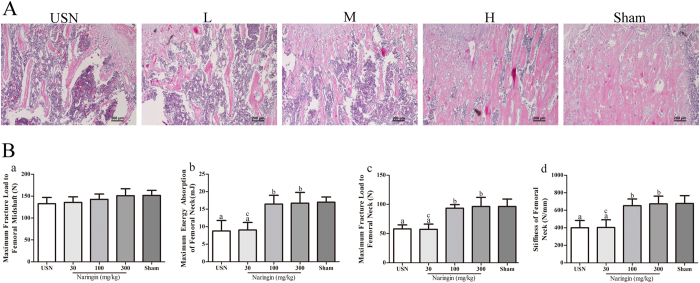
Pathological observation of the distal femoral metaphysis in each group as stained by HE (A). Effects of the prophylactic administration of naringin on the prevention of the deterioration of biomechanical properties of the ipsilateral femurs for 4 weeks after USN (B). The upper panel: A photograph of the longitudinal section at the distal femoral metaphysis shows that the preventative application of higher doses of naringin significantly alleviates the destruction of cancellous bone microarchitecture caused by USN (A). The lower panel: A three-point bending test was performed to assess the bone strength of the femoral shaft, while a compression test was conducted to determine that of the femoral neck. (a) The maximum load of femoral diaphysis, and (b–d) the energy absorption, maximum fracture load and stiffness of femoral neck (B). ap < 0.05, aap < 0.01, aaap < 0.001 vs. Sham group. bp < 0.05, bbp < 0.01, bbbp < 0.001 vs. USN group. cp < 0.05, ccp < 0.01, cccp < 0.001 vs. 300 mg/kg Naringin group. L represents the 30 mg/kg Naringin group, M the 100 mg/kg Naringin group, and H the 300 mg/kg Naringin group. Magnification ×100. One-way ANOVA.